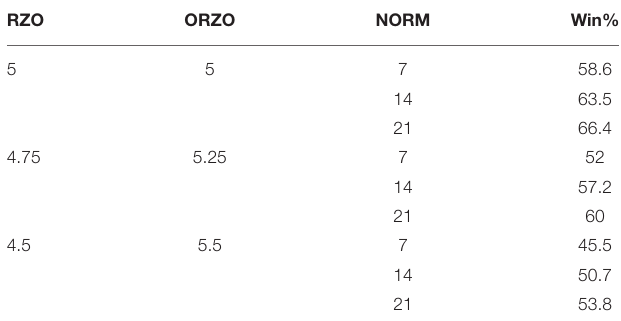
TABLE 6 | Example parameters and win